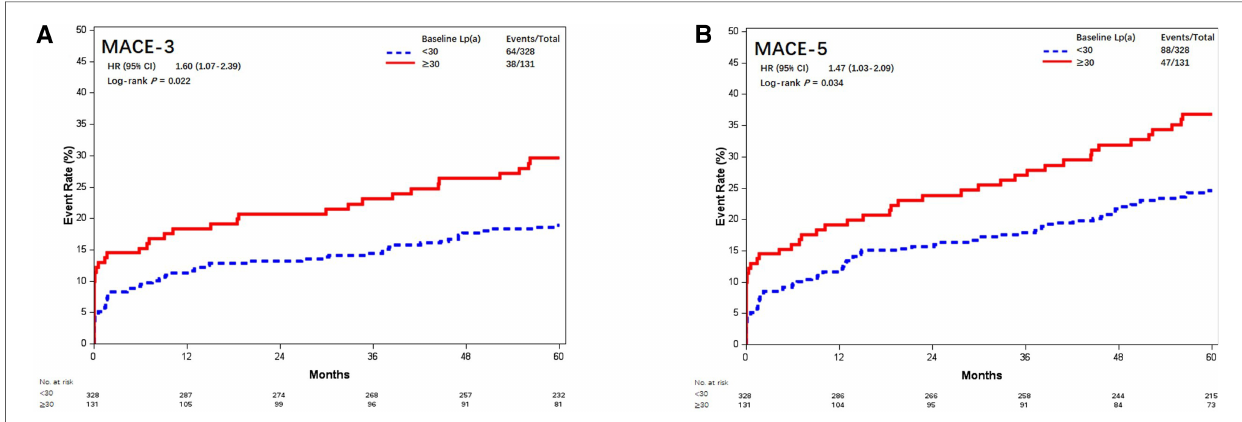
FIGURE 6 Kaplan – Meier curves of MACE-3 and MACE-5 between different baseline Lp(a) levels (mmol/L). Kaplan – Meier estimates for freedom from ( A ) MACE-3 and ( B ) MACE-5. Lp(a), lipoprotein(a); MACE-3, 3-point major adverse cardiovascular events; MACE-5, 5-point major adverse cardiovascular